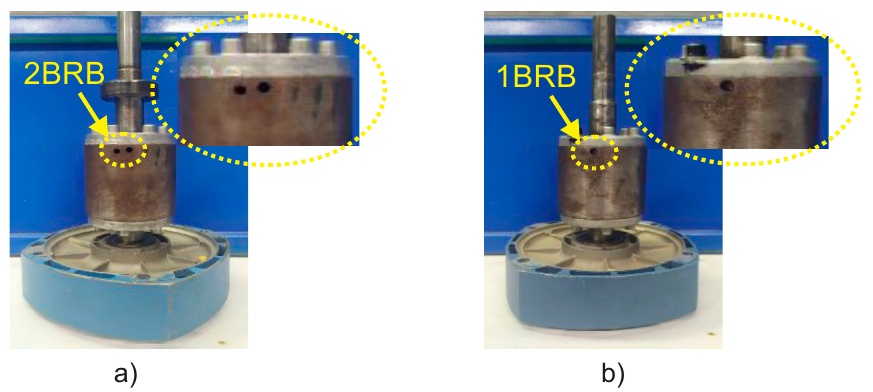
Figure 12. ( a ) Two broken rotor bars; ( b ) one broken rotor bar.